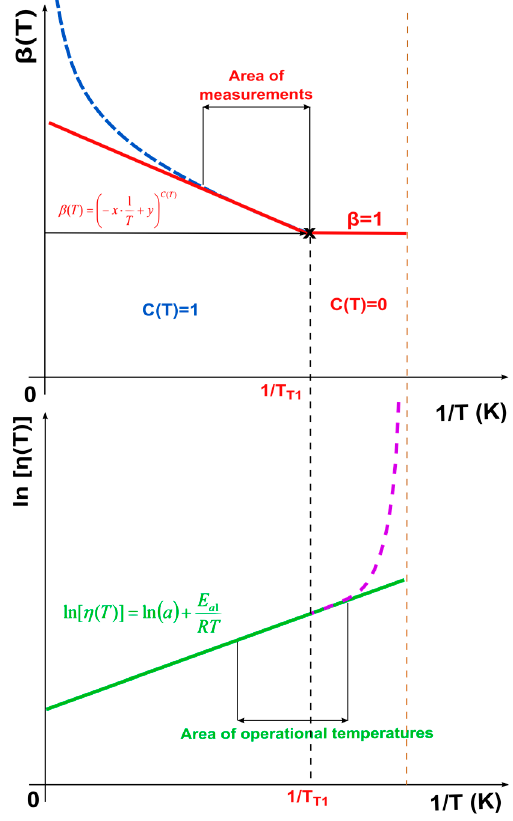
Figure 6. Determination of threshold value of the effect of degradation factor.